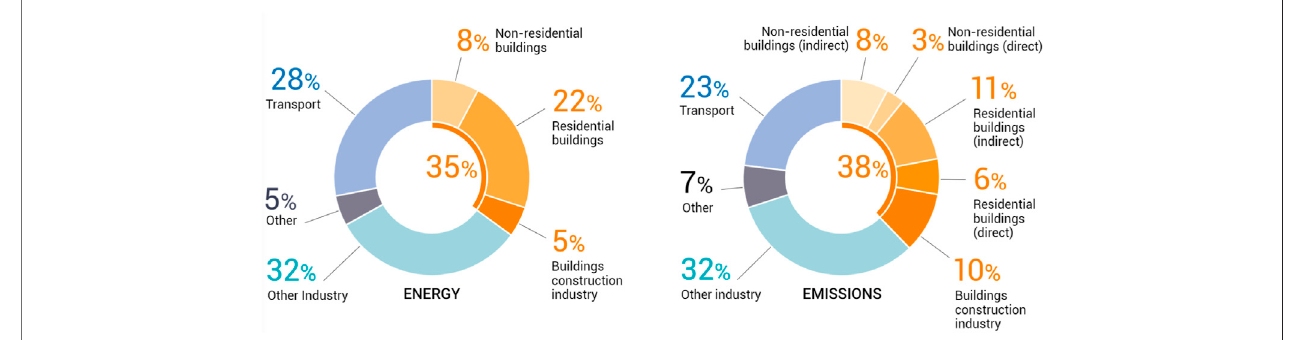
FIGURE 1 | Global share of buildings and construction fi nal energy and emissions, 2019. Figure obtained from (lobalnvironmen, 2020).